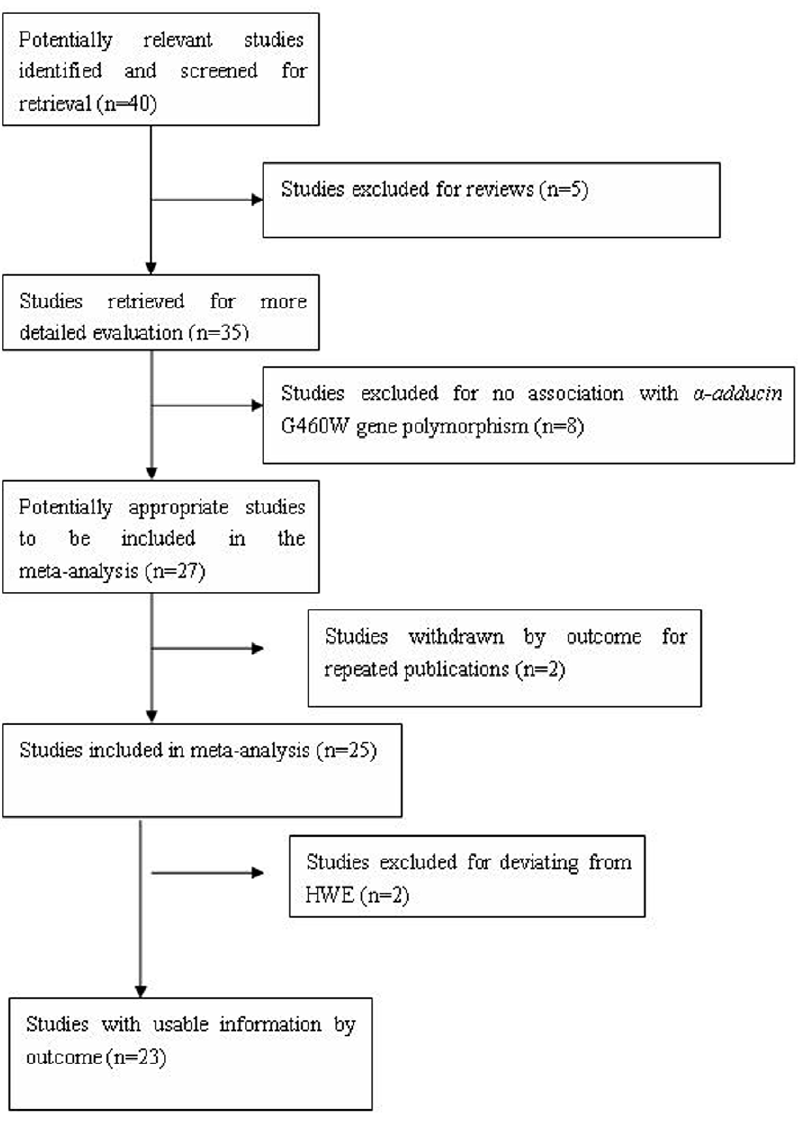
Figure 1. Flow diagram of articles selection process for a -adducin G460W gene polymorphism and EH risk meta-analysis.